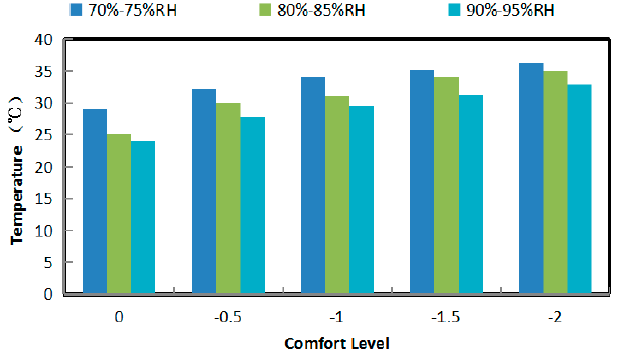
Figure 7. Temperature changes under the same conditions.